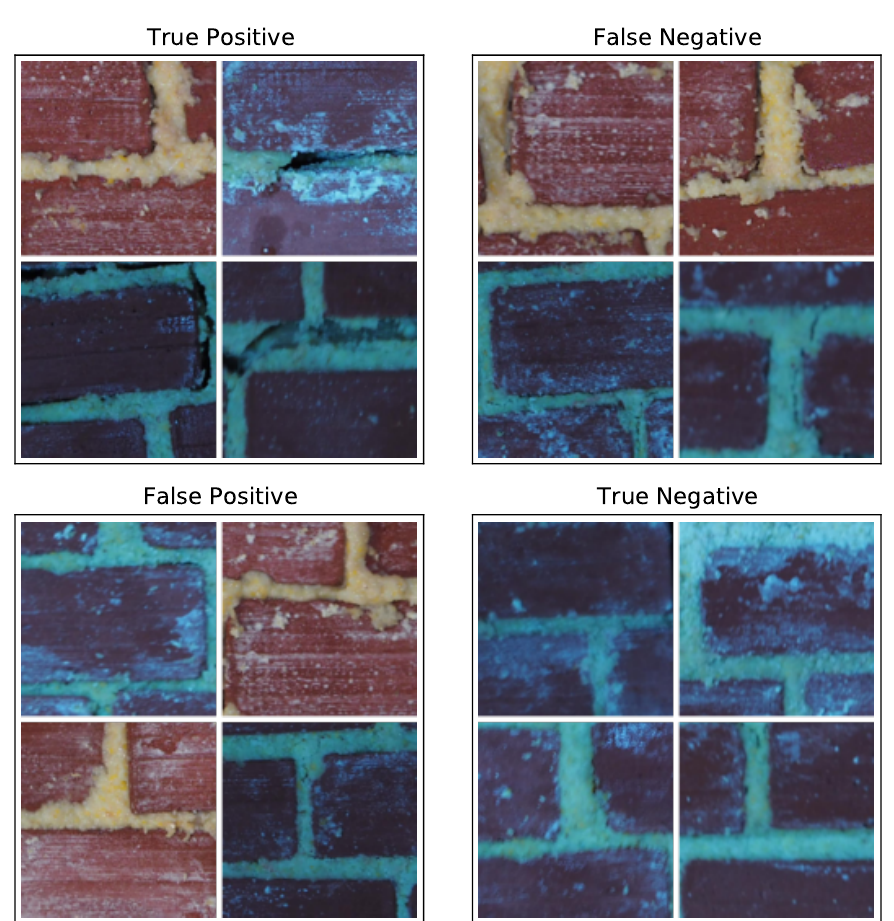
Figure 7. A random sample of four lab images from each case in the confusion matrix, as determined by Model C.